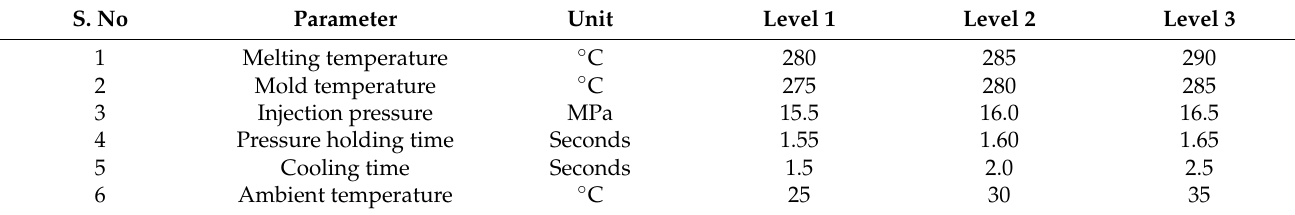
Table 2. Parameters and their